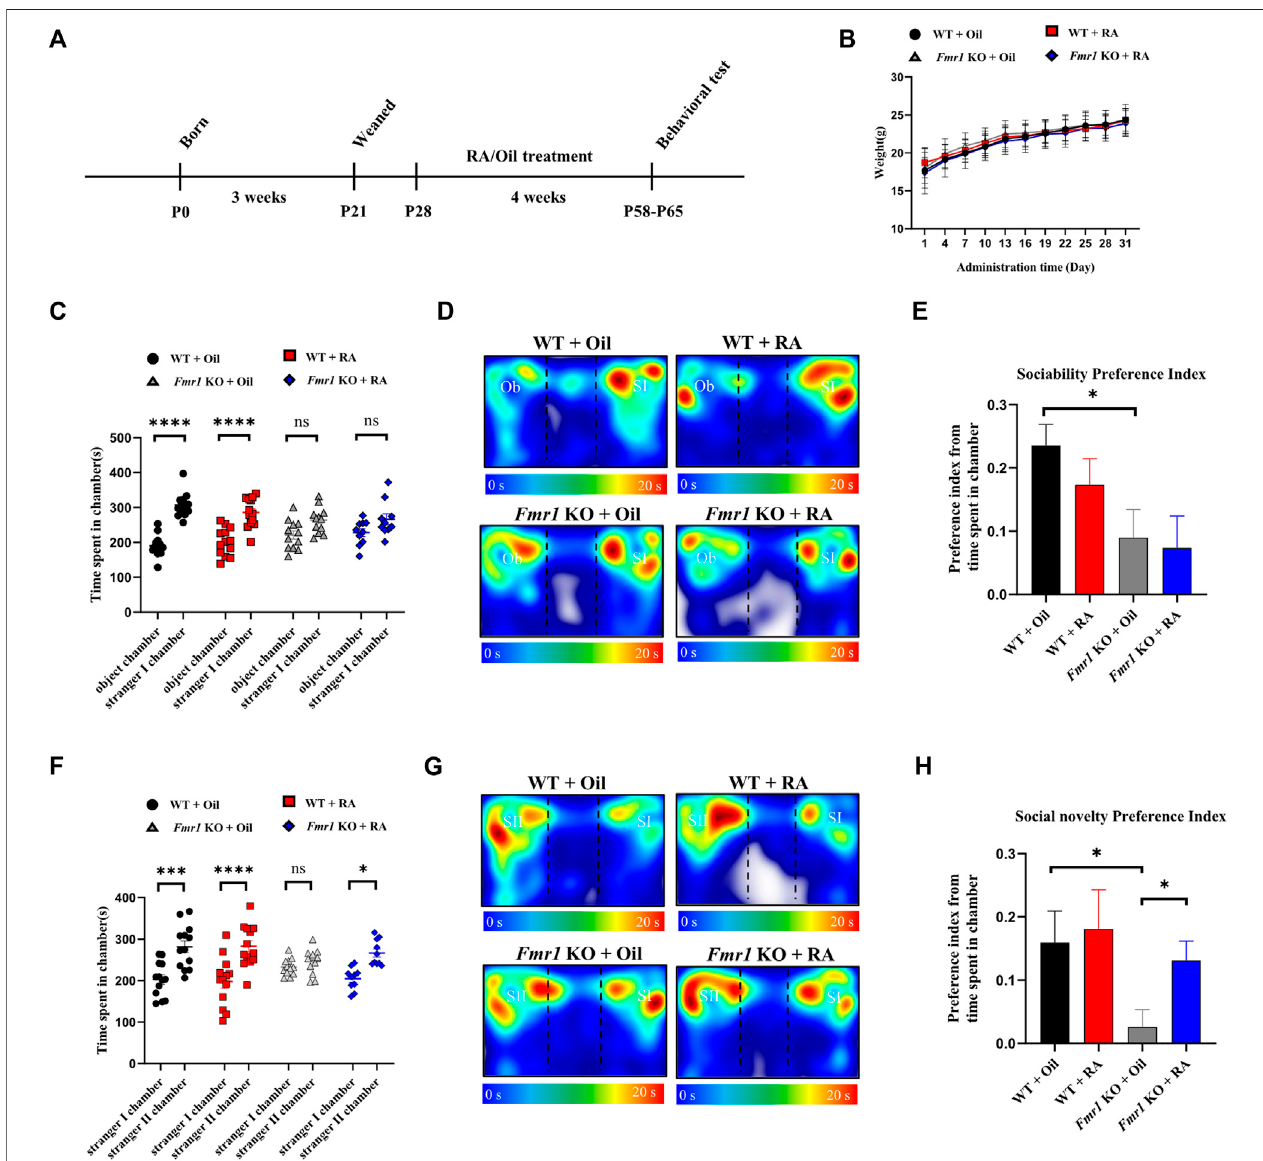
FIGURE2| RAadministration restores socialnovelty behaviorin Fmr1 KO mice. (A) Schematic diagram ofexperimental design.WT and Fmr1 KO male mice were orally administered with Oil or RA (5 mg/kg/d) for 4 weeks, before subjected to behavioral tests at postnatal day P58-P65. (B) Body weights of mice recorded every 4days for 1 month after Oil orRAadministration.WT +Oil (n=13), WT +RA(n=13), Fmr1 KO +Oil (n=13), Fmr1 KO +RA(n=12). (C – E) Time spent ineach chamber (C) ,representativeheatmap (D) andthepreferenceindex (E) forthesociabilitytestperformedwith4groupsofmice.TheObandSIindicatetheobjectandstranger Ⅰ ,respectively.WT+Oil(n=13),WT+RA(n=13), Fmr1 KO+Oil(n=12), Fmr1 KO+RA(n=10). (F – H) Timespentineachchamber (F) ,representativeheatmap (G) and the preference index (H) for the social novelty test performed with 4 groups of mice. The SI and SII indicate the stranger Ⅰ and stranger Ⅱ , respectively. WT + Oil (n = 13), WT+RA(n=13), Fmr1 KO+Oil(n=12), Fmr1 KO+RA(n=10).Dataarepresentedasmeans±SEM.* p < 0.05,*** p < 0.001,**** p < 0.0001,ns,notsigni fi cant. (B,C,F) Two-way ANOVA with Bonferroni post hoc test ; (E,H) Unpaired two-tailed t test with Welch ’ s